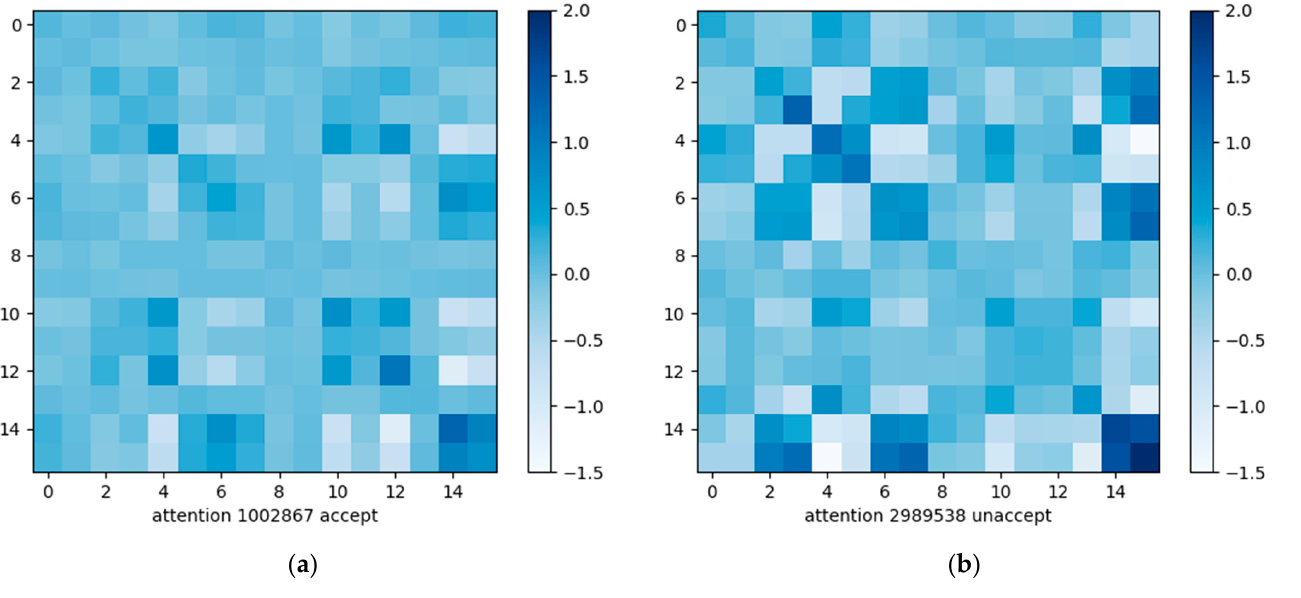
( b ) Figure 8. ( a ) An acceptable sample plot corresponds to ( a ) in Figure 7; ( b ) an unacceptable sample plot corresponds to ( b ) in Figure 7. 5. Discussion With the gradual improvement of intelligent medical systems, improving the accu- racy of automated analysis techniques of physiological signals and reducing the complex- ity of models have become the main directions of current research. In this paper, consid- ering the sudden and fatal nature of cardiovascular diseases, we design an automated ECG signal quality assessment method to screen out valid ECG signals for subsequent early screening of abnormal ECG signals and to improve the efficiency of healthcare work- ers. The method is designed based on a modified Resnet and combined with a self-atten- tive module we designed in this paper. The design of this model not only avoids a lot of feature engineering design work caused by using traditional machine learning, but also avoids the problem of model performance degradation caused by a too-deep network